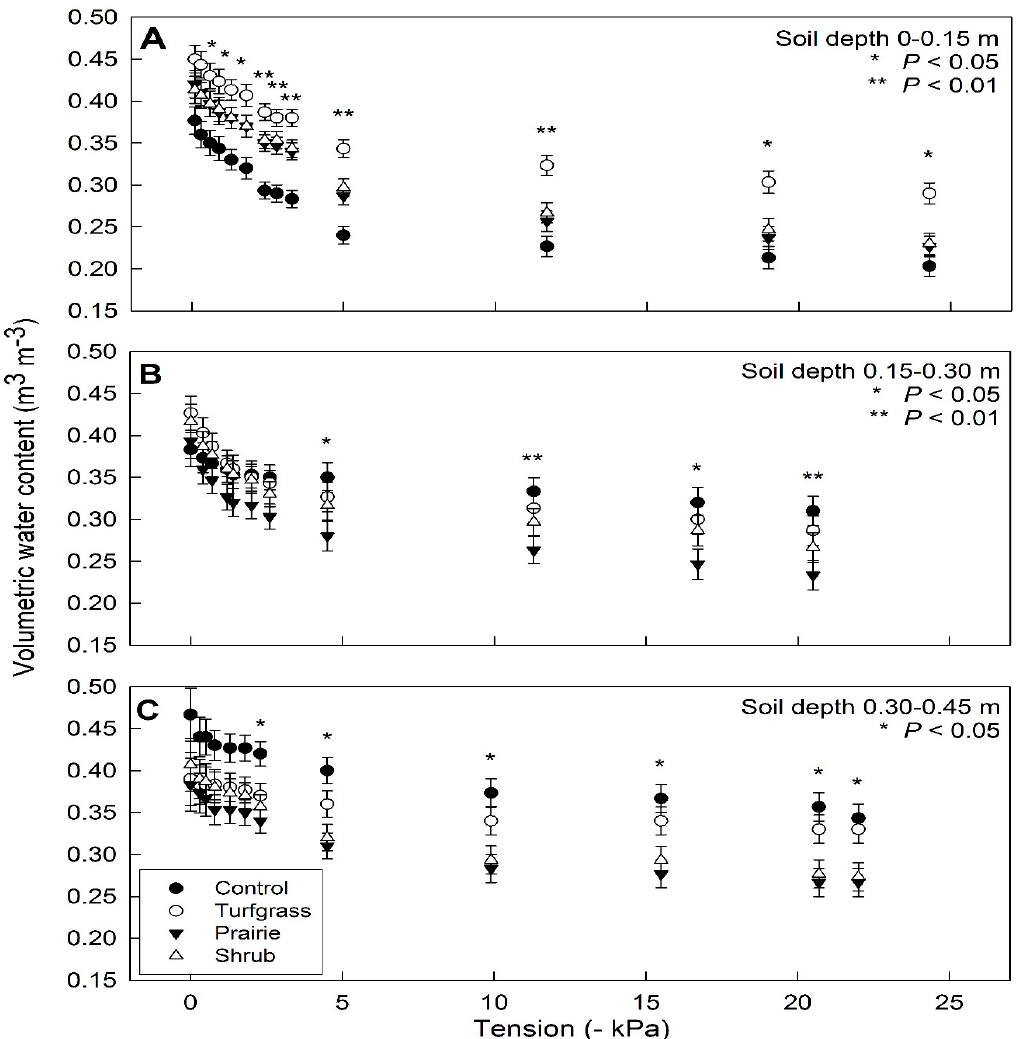
Figure 7. Soil-water retention curves of intact soil cores sampled at three depths: ( A ) 0–0.15 m, ( B ) 0.15–0.30 m, and ( C ) 0.30–0.45 m. Asterisks indicate significant differences in soil moisture (m 3 m − 3 ) among treatment means at each soil tension ( p < 0.05). Plotted values are means ± SEM.